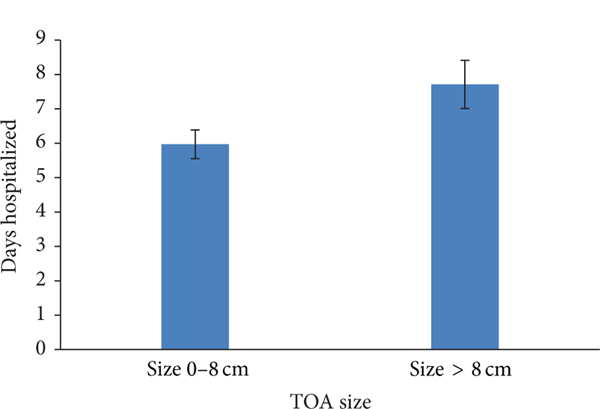
Mean duration of hospitalization in days with standard errors for comparison. TOA of larger size were hospitalized for a greater duration of time. Patients with a TOA measuring 0–8 cm were hospitalized for 5.97 days (SE 0.42), while those greater than 8 cm were hospitalized for 7.71 days (SE 0.7), (P < 0.029).